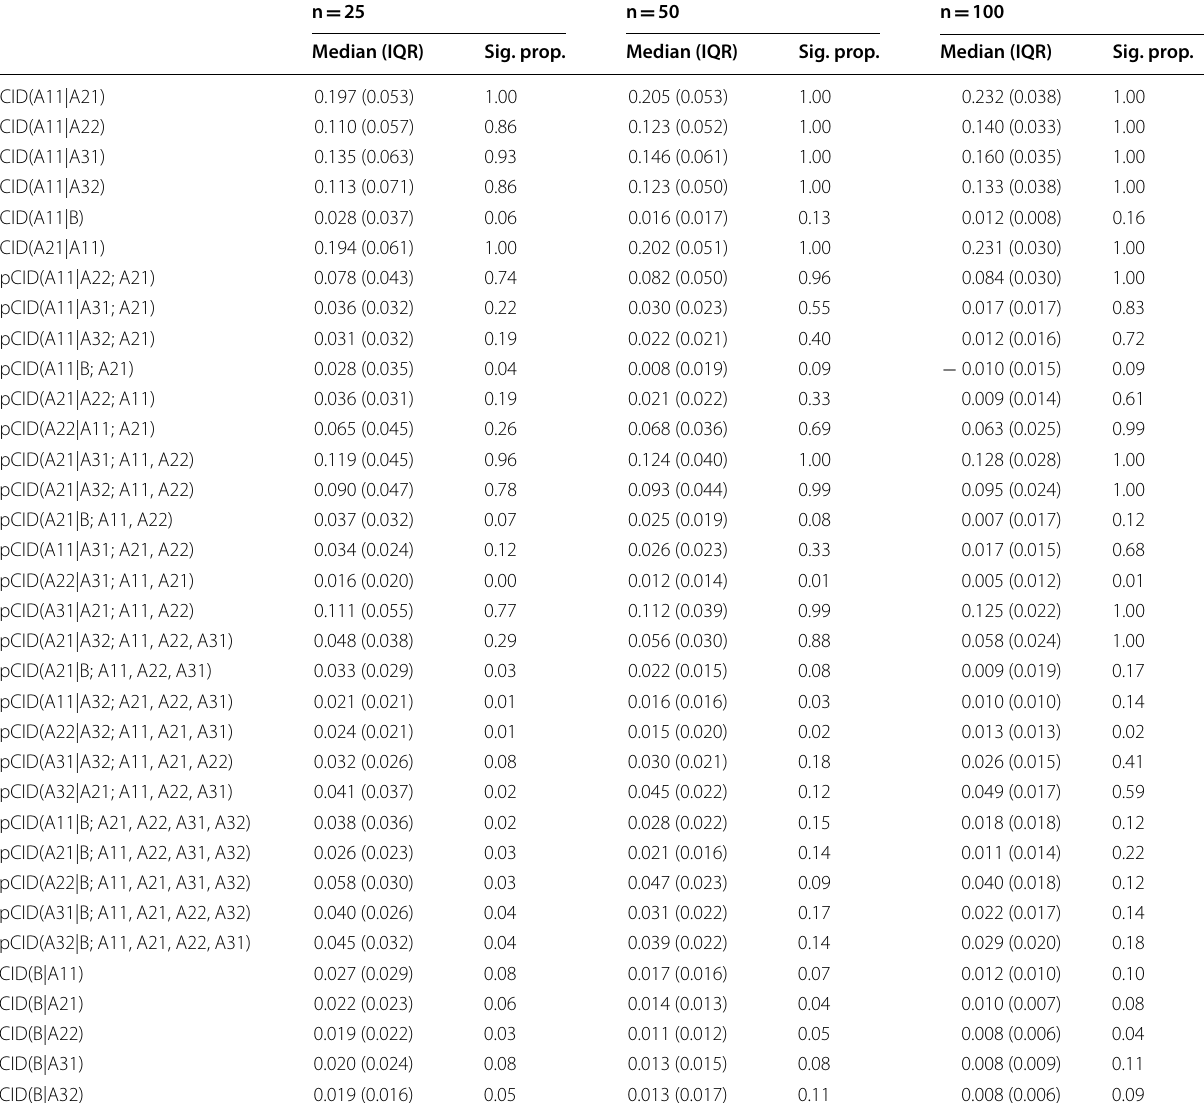
Table 3 Summary of estimated CID and pCID values in 100 simulations